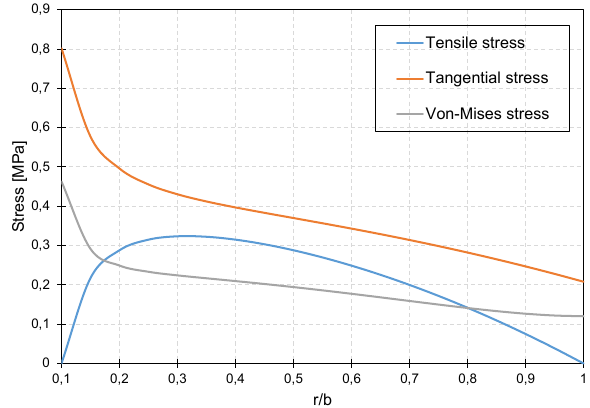
Figure 4: Stress versus the ratio of r to b, where a=0.1 and